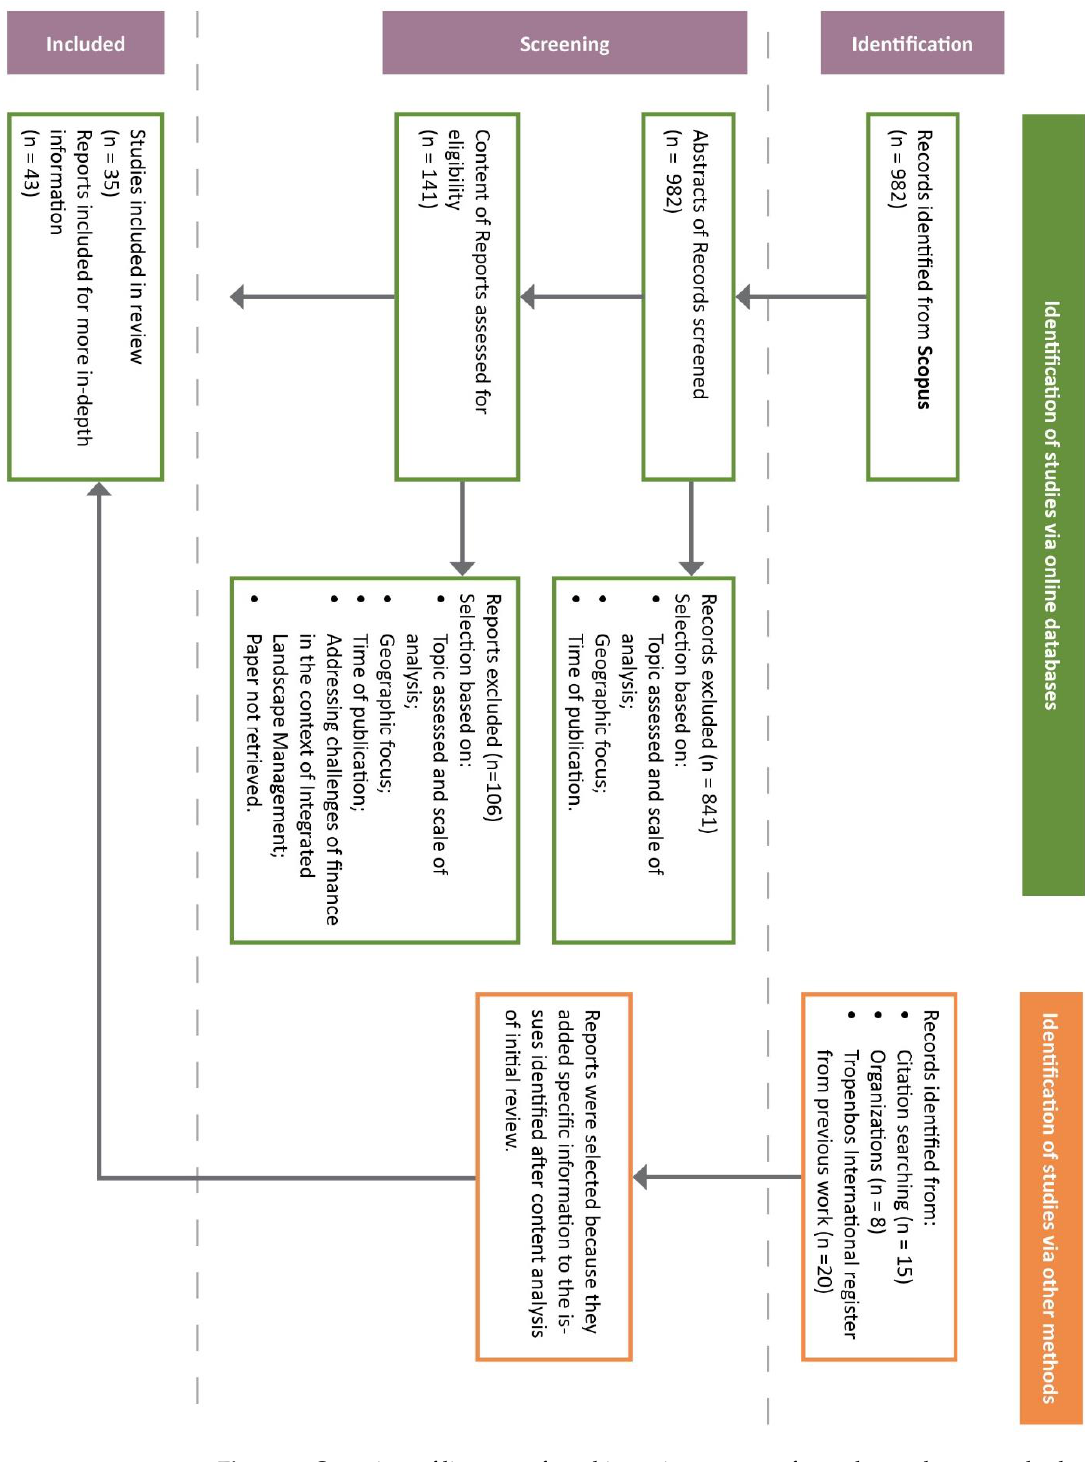
Figure 2. Overview of literature found in various sources for each search term and selection criteria used (modified from [22]).